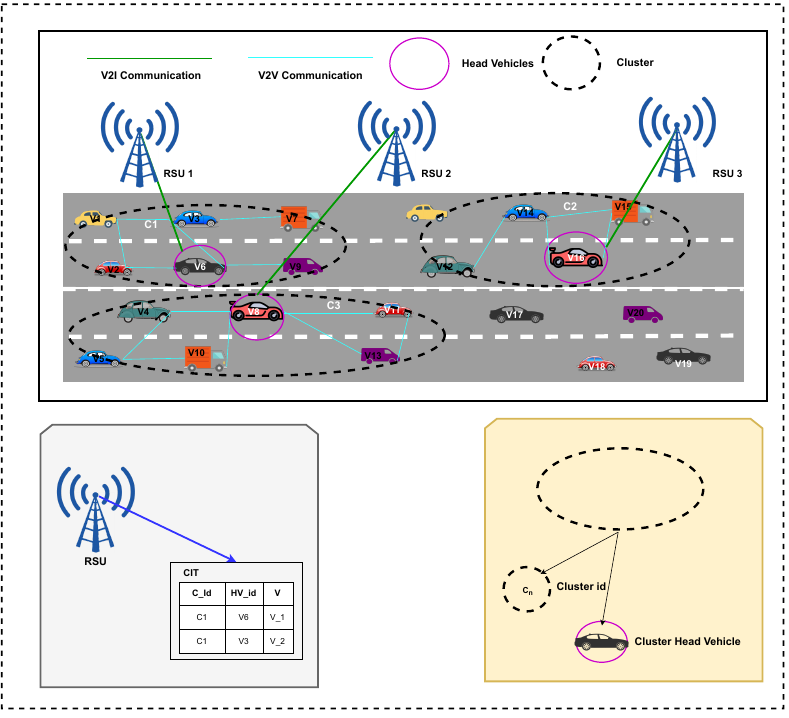
Figure 1. System Model of Proposed Scheme. Initially, the distance between sender and receiver vehicles has been calculated. Equation (1) is used to calculate the Euclidean distance d i between two vehicles. The i shows any number of vehicles i = { i 1 , i 2 , i 3 , ..., i n } . d x 1 is the x-coordinate and d y 1 is the y-coordinate of the sender vehicle. d x 2 is the x-coordinate and d y 2 is the y-coordinate of the receiver vehicle. After receiving the location information from the one-hop